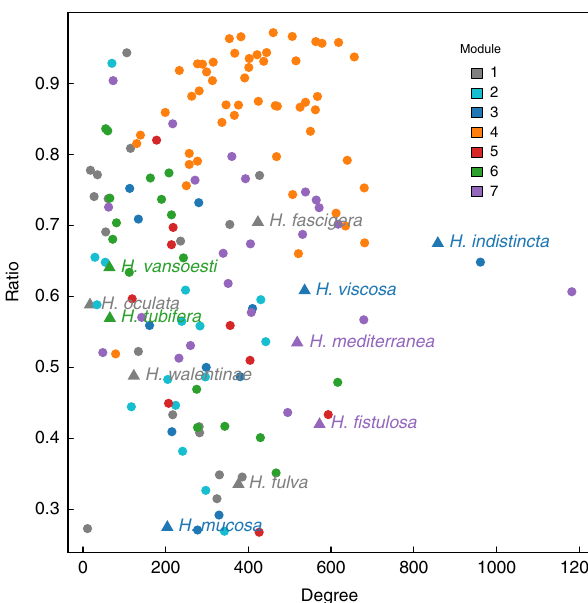
Fig. 4 Microbial abundance drives sponges ’ network connectivity. Within- module degree ( z ) vs. participation coef fi cient ( P ) for the sponges the core network. Different colour classes show different sponge types, divided into high- and low-microbial abundant species (HMA and LMA, respectively). NA = no microbial abundance classi fi cation is available. LMA sponges than HMA ones, i.e. larger P (KS test: D = 0.57601, p -value <